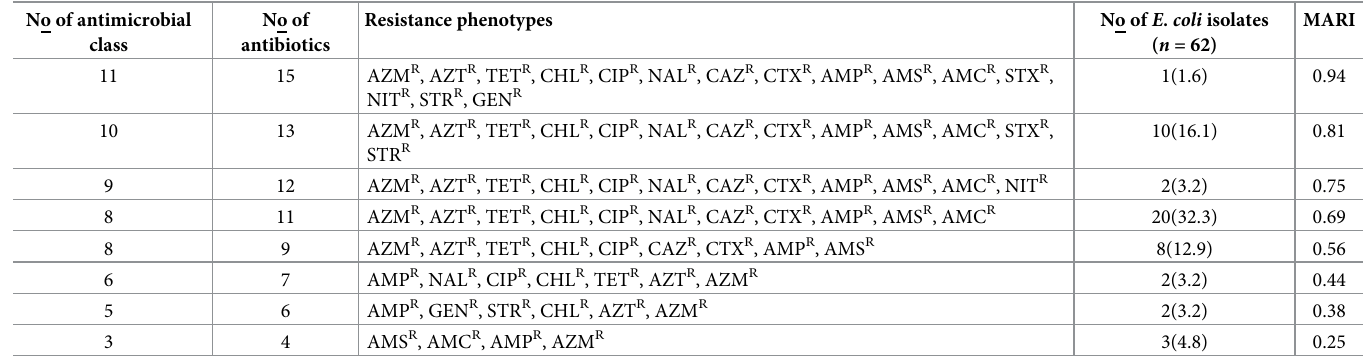
Table 3. Multidrug resistance (MDR) and multiple antibiotic resistance index (MARI) profile of the E . coli isolates. No of antimicrobial